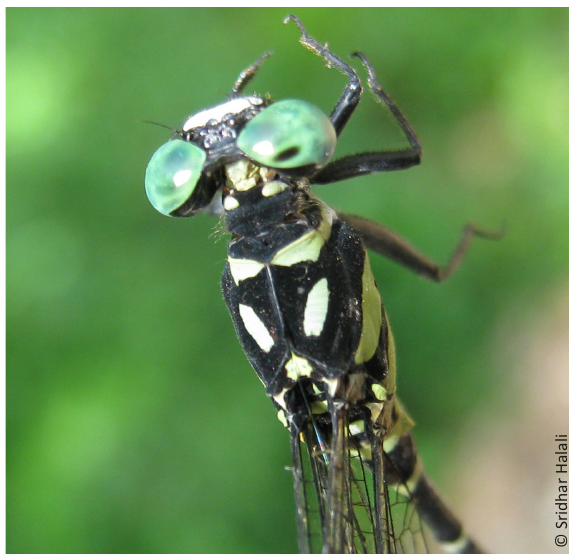
Upper surface of frons is greenish-white. Base of antennas black. Vertex and occiput black. Eyes bottle green and not confluent